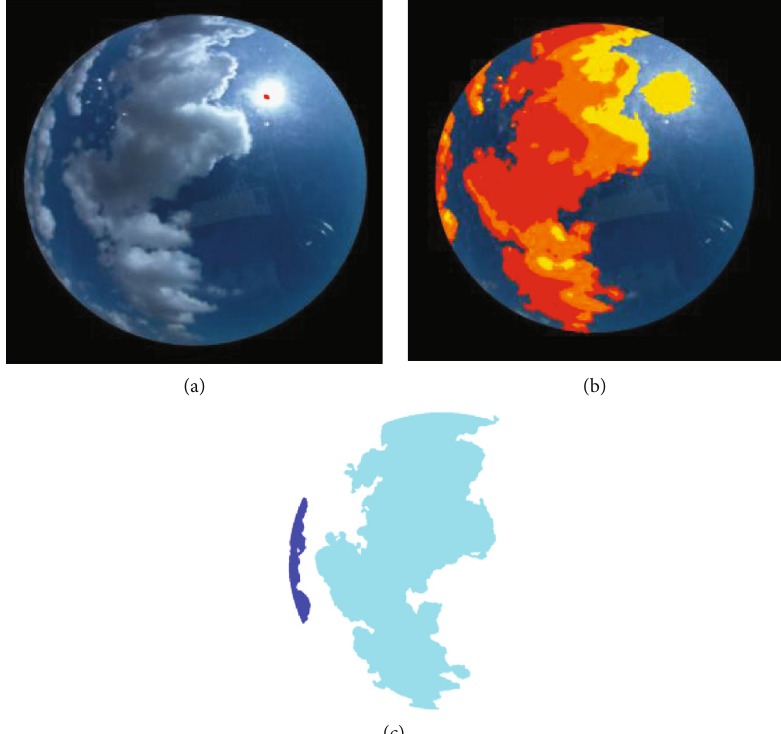
Figure 9: (a) RGB raw image with calculated position of the sun. (b) Identi fi ed white patches including both the sun and clouds in the sky image are marked on the RGB image. (c) Separately identi fi ed cloud regions (area without